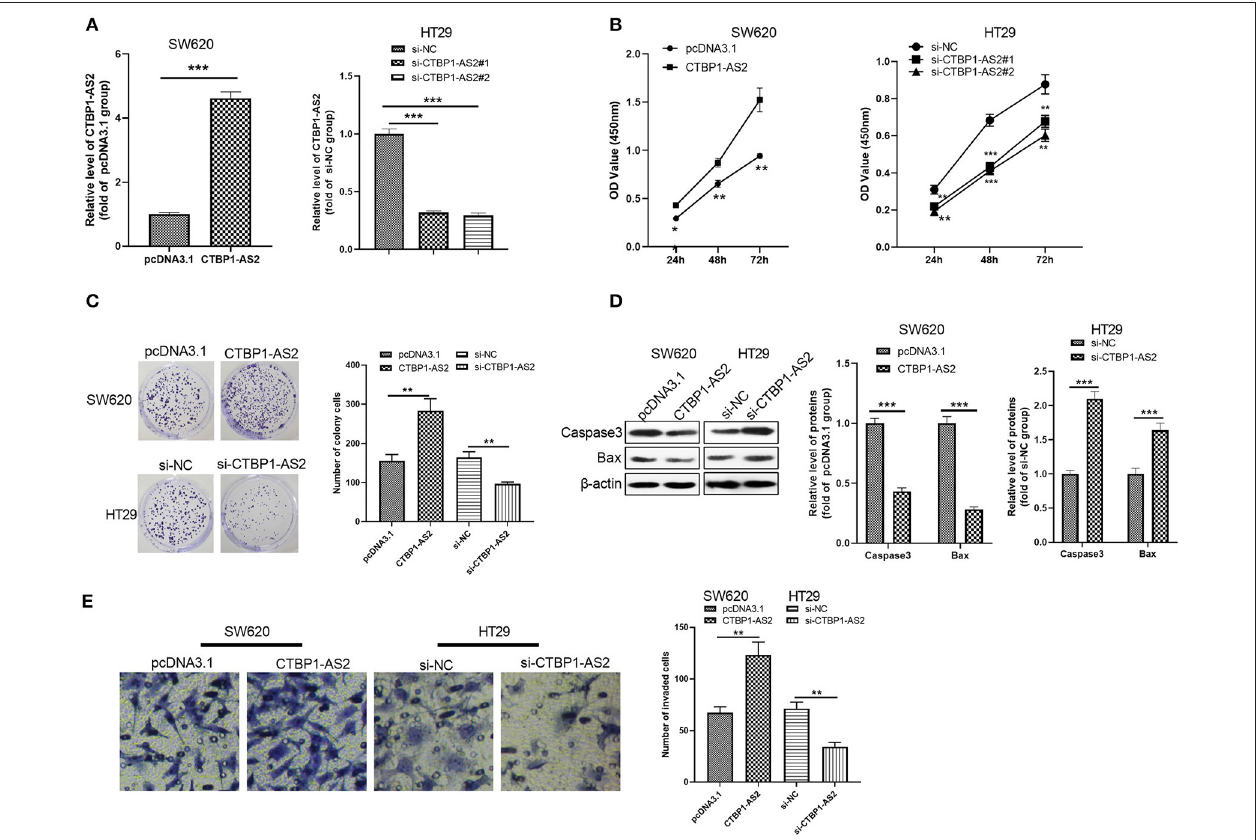
FIGURE 2 | Regulation of CTBP1-AS2 on CRC proliferation, apoptosis, and invasion. (A) SW620 cells transfected with CTBP1-AS2 overexpression plasmids or pcDNA3.1, and HT29 cells transfected with si-CTBP1-AS2 or si-NC. Performing RT-PCT to measure CTBP1-AS2 expression in the two cell lines. (B) Incubation of SW620 and HT29 cells in the 96-well plates for different time points (24, 48, and 72h). Use of CCK-8 assay to examine cell proliferation with different levels of CTBP1-AS2. * p < 0.05, ** p < 0.01, *** p < 0.001 vs. pcDNA3.1 group or si-NC group. (C) Examination of cell proliferation of SW620 and HT29 cells through colony formation experiments. (D) Detection of apoptosis-related proteins caspase-3 and Bax expressions in SW620 and HT29 cells using Western blotting. (E) Use of the Transwell method to measure cell invasion of SW620 and HT29 cells. ** p < 0.01, *** p < 0.001. N = 3. CCK-8, cell counting kit-8; CRC, colorectal cancer; RT, reverse transcription; si-NC, small interfering RNA negative